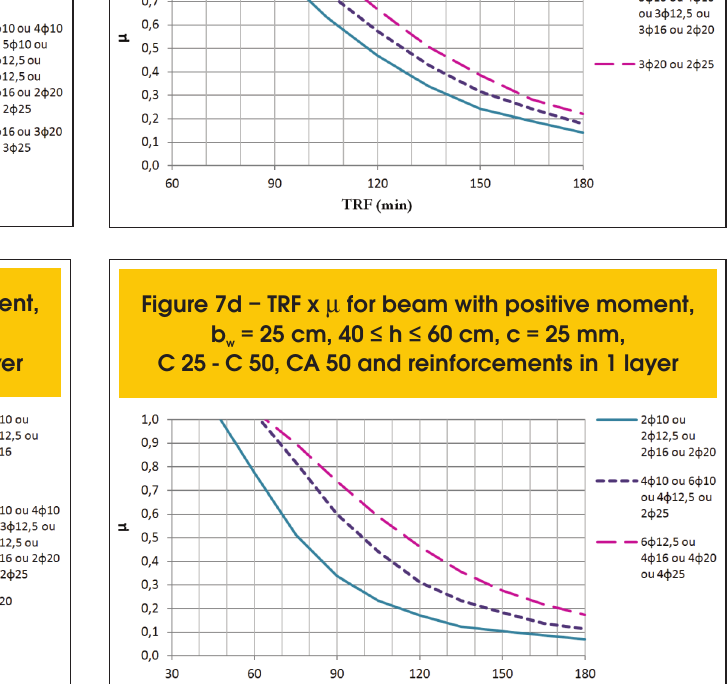
Figure 7c – TRF x m for beam with positive moment, b = 19 cm, 40 ≤ h ≤ 60 cm, c = 40 mm, w C 25 - C 50, CA 50 and reinforcements in 1 layer